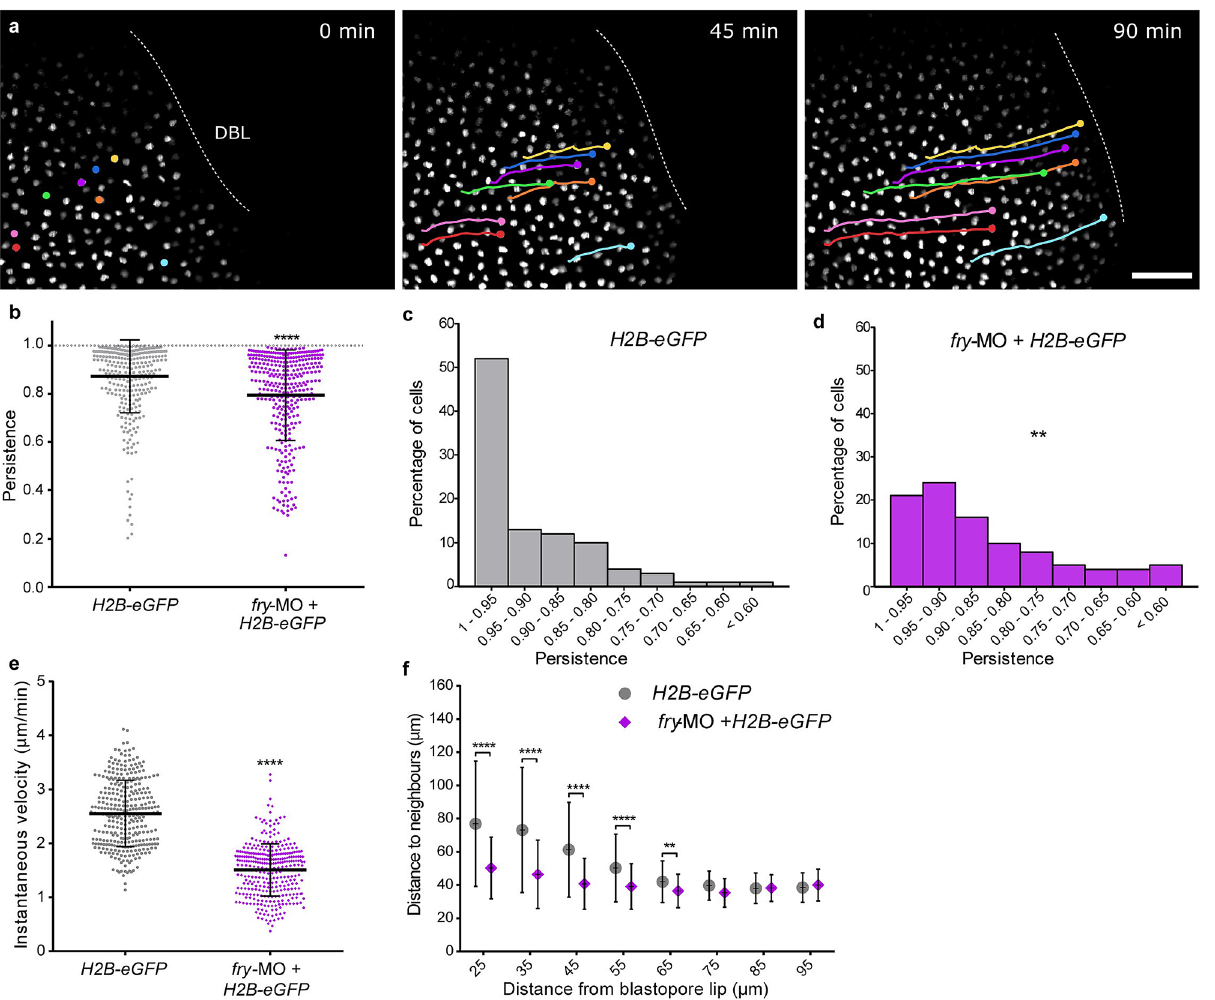
Figure 4. Fry depletion affects the motion of superficial involuting marginal zone cells. ( a ) Xenopus 4-cell stage embryos were dorsally injected with H2B-eGFP mRNA with or without fry -MO (15 ng) and mounted for light- sheet fluorescence microscopy at the beginning of gastrulation (St. 10). Time lapse movies were recorded during gastrulation and individual cells were tracked while moving toward the dorsal blastopore lip (DBL) (e.g. nuclei in color. Circles and lines indicate nuclei position and trajectory, respectively). H2B-eGFP mRNA (N = 5; total number of tracked cells = 319); H2B-eGFP mRNA + fry -MO injected embryos (N = 5; total number of tracked cells = 332). N: number of independent experiments. Representative images from time-lapse movies at selected time-points (t) are shown. Scale bar: 100 μm. ( b ) Individual cell persistence measurements were calculated as the ratio between the linear distance traveled by the cell and the total length of its path. Each point represents a single cell. Statistical significance was evaluated using two-tailed Mann Whitney U -test. **** p < 0.0001 indicates statistically significant differences between groups. The mean and standard deviation are indicated. ( c ) Histogram representing the percentage of cells from control embryos ( H2B-eGFP ) for the different persistence intervals. ( d ) Histogram representing the percentage of cells from fry- MO + H2B-eGFP embryos for the different persistence intervals. Statistical significance was evaluated using Chi -square test. ** p < 0.001 indicates statistically significant differences were found between groups. ( e ) Individual cell instantaneous velocity measurement. The mean and standard deviation are indicated. Each point represents a single cell. Statistical significance was evaluated using two-tailed Mann Whitney U -test. **** p < 0.0001 indicates statistically significant differences between groups. ( f ) Average distance from each cell nucleus to the nearest neighbors for all cells within a certain distance region from the blastopore lip (region size = 30 μm; overlapping region size = 5 μm). Distance to neighbors was quantified from the 150 min time point onward (St. 11.5) of the movies shown in a. Number of cells in each window was always larger than 100 cells. Data in the graph is presented as means with standard deviation. Statistical significance was evaluated using Kruskal–Wallis test and Dunn’s multiple comparisons test. **** p < 0.0001 and ** p < 0.01 indicate statistically significant differences between